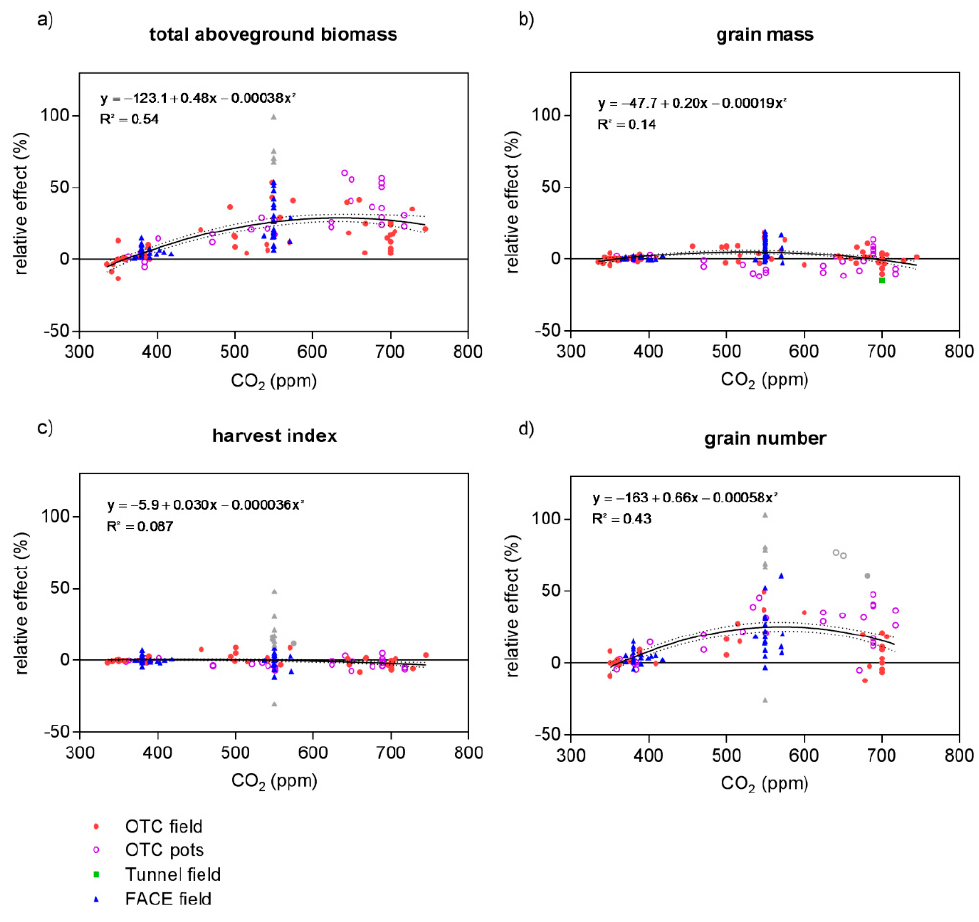
Figure 4. Response function for ( a ) total aboveground biomass, ( b ) grain mass, ( c ) harvest index, and ( d ) grain number with CO 2 concentration (relative to yield at 350 ppm). Dotted lines give the 95% confidence interval for the regression model. Grey markers are statistical outliers excluded from the curve fitting. Based on the observation that the response pattern for the grain number was similar to grain yield,